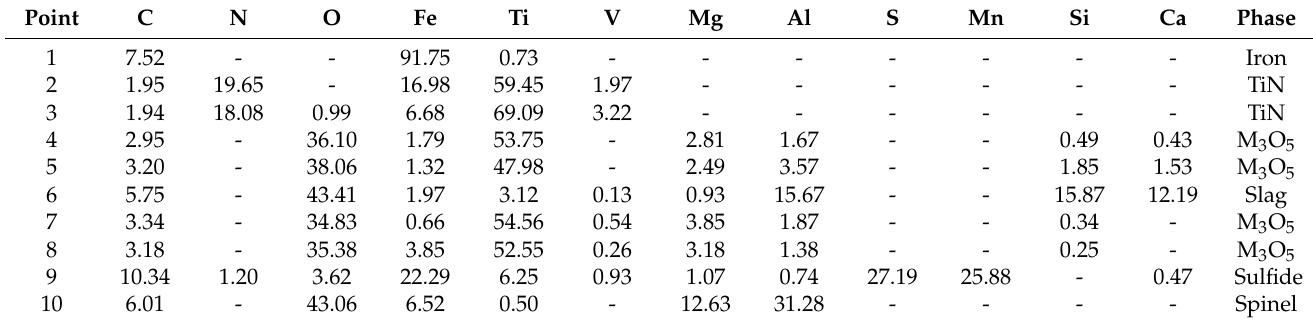
Figure 6. Microstructure and EDS results of the pellets roasted at 1200 ◦ C for 90 min: ( a ) typical SEM image; ( b ) the reduced titanomagnetite; ( c ) the reduced ilmenite; ( d ) V, Ti, N, and Fe elemental maps of the area shown in ( b ). Table 6. Elemental composition of points shown in Figure 7